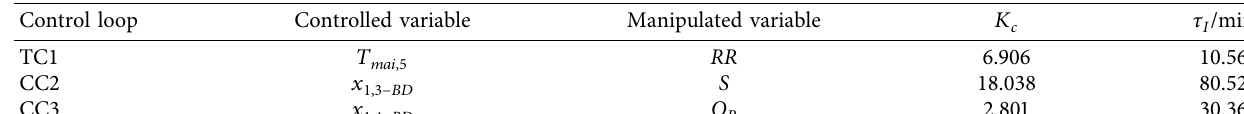
Figure 7: Cascade control structure CS3 of DWC. Table 4: Controller tuning parameters of CS3.